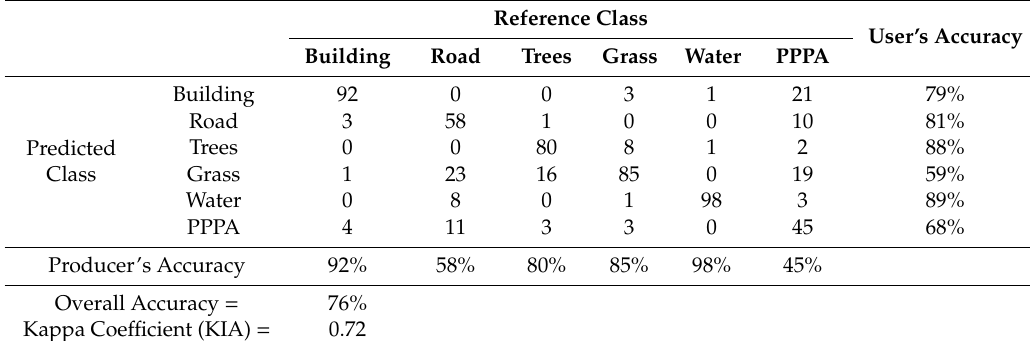
Table 7. Confusion Matrix for classification using Bayesian classifier followed by refining